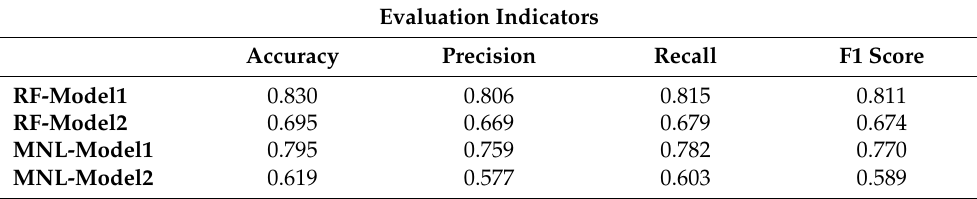
Table 2. Comparison of model evaluation indexes.